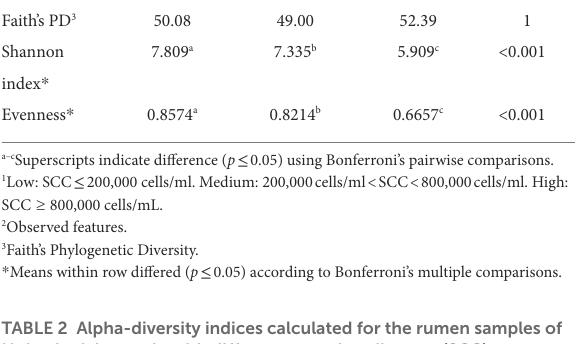
TABLE 2 Alpha-diversity indices calculated for the rumen samples of Holstein dairy cattle with different somatic cell count (SCC) ranges at time of collection: low, medium, or high.